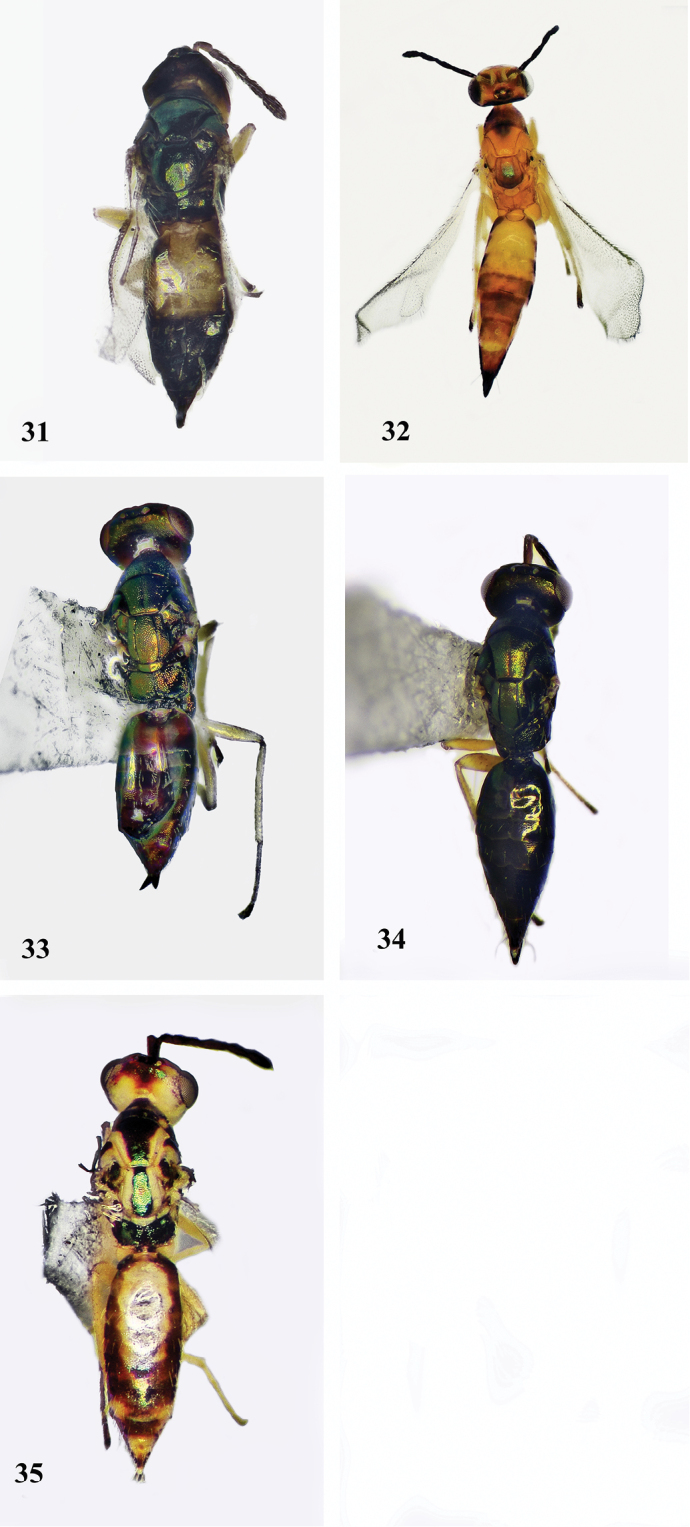
Females, dorsal view 31Neotrichoporoides
basiflavus sp. nov. 32Neotrichoporoides
flavothorax sp. nov. 33N.
szelenyii34N.
nyemitawus35N.
viridimaculatus